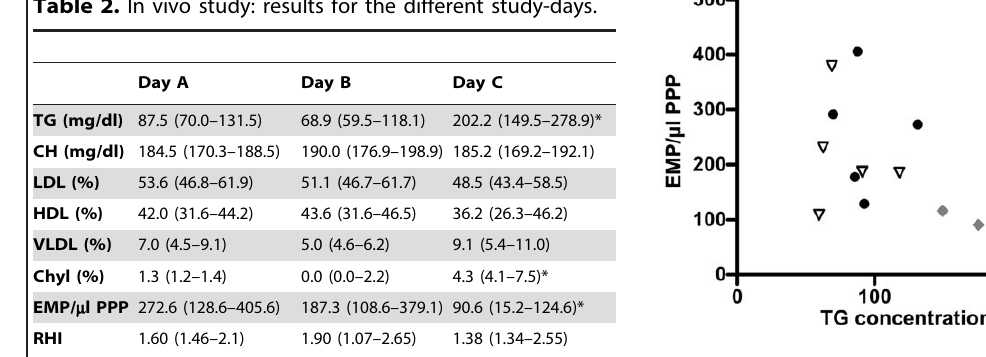
Figure 4. In vivo there is a non-linear inverse relation between TG concentration and EMP detected in plasma. 5 healthy volunteers were evaluated on 3 different study days. Day A: blood was collected after an overnight fast. EMP were detected by flow cytometry as particles , 1 m m and CD31 + /CD42b 2 in PPP, and lipid profile was determined on frozen plasma samples. (Black dots) Day B: NaCl 0.9% was administered in fasting conditions and the same measurements as on day A were performed. (Black open triangles) Day C: the same protocol was used as on day B, but a pure lipid solution was infused instead of NaCl. (Gray diamonds) There is an inverse non-linear